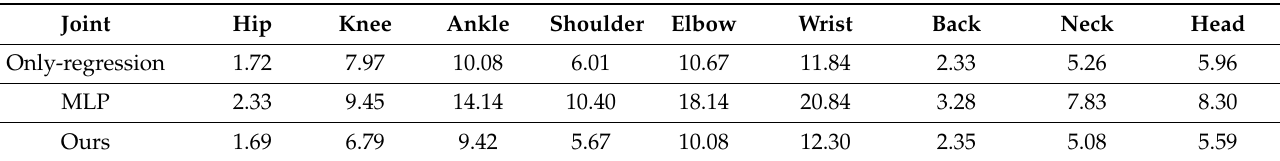
Table 3. Evaluation of the position error of each joint in cm. Average distance error detection was performed on nine key joints of the human body on the DIP-IMU